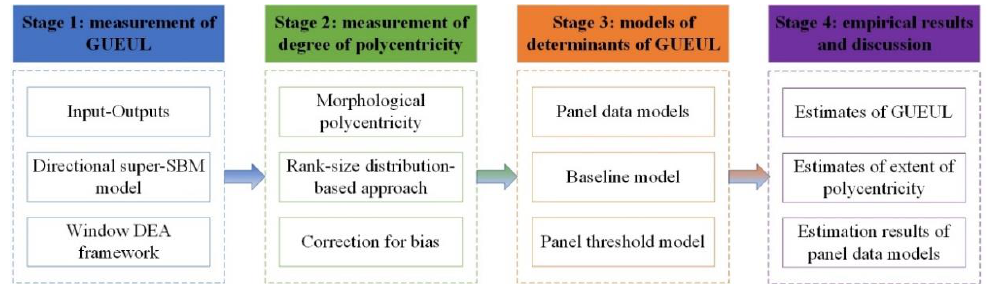
Figure 2. Research process of this study.